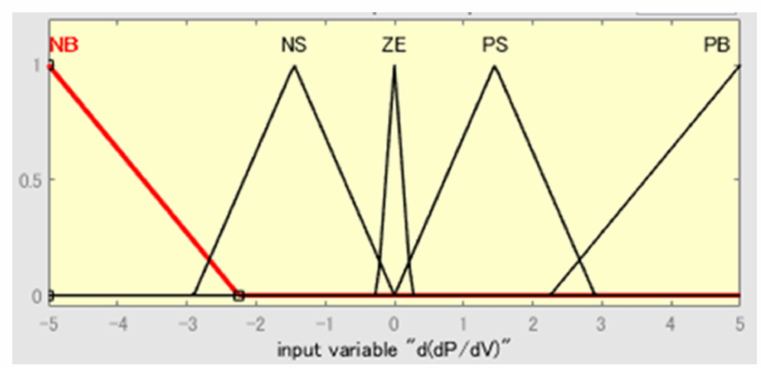
Figure 9. PV FLC membership function for CE [32].